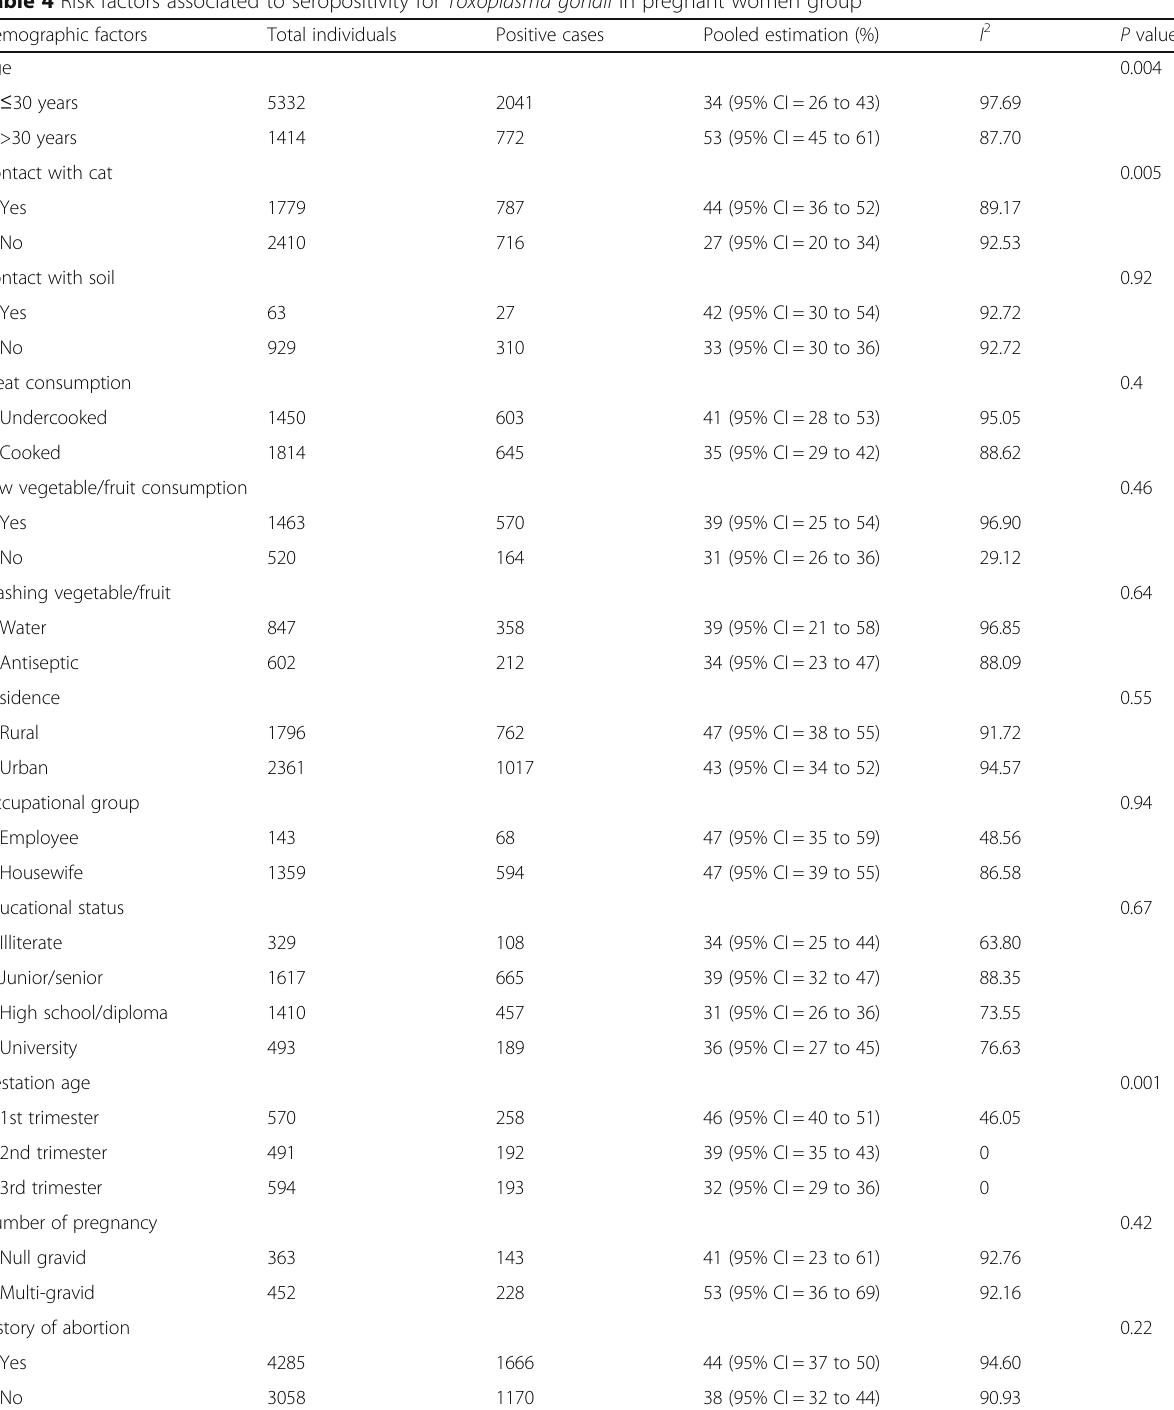
a Meta-regression